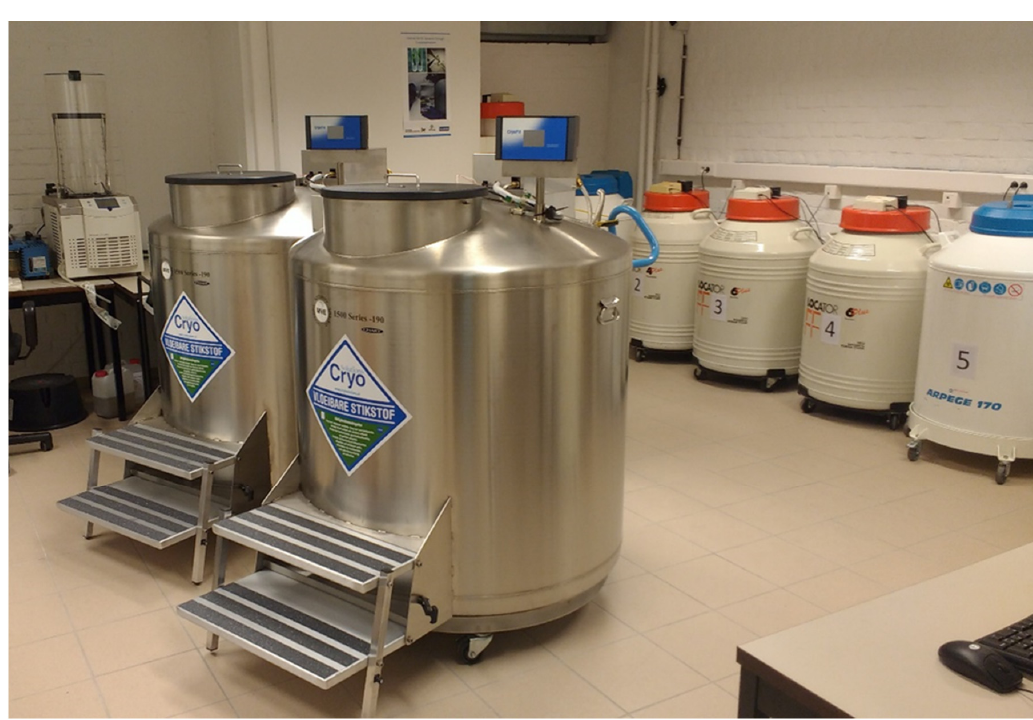
Figure 4. Cryopreservation facilities at the ITC.